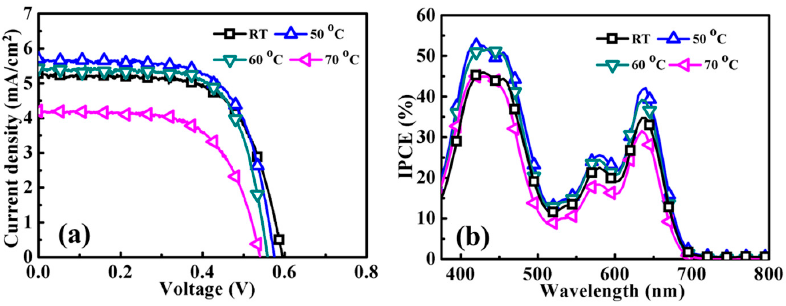
Figure 4. ( a ) J–V curves and ( b ) IPCE spectra of YD2-o-C8-TBA-sensitized ZnO DSSCs with photoanodes prepared using ethanol solutions of 0.1 mM YD2-o-C8-TBA and 2.5 mM CDCA for 15 h at different temperatures.